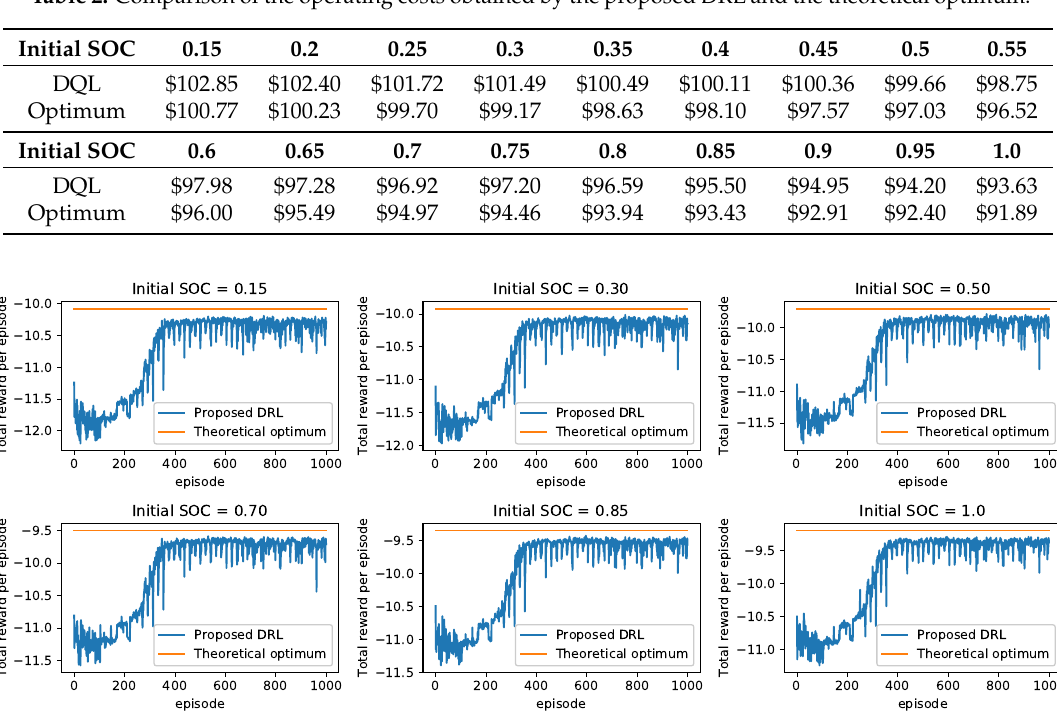
Figure 3. Learning curves of the proposed DRL approach for the deterministic scenario. The proposed DRL approach learned a stable policy after 400 episodes of training. The learned policy performs well on different initial conditions of the ESS, achieving high rewards that are very close to the theoretical